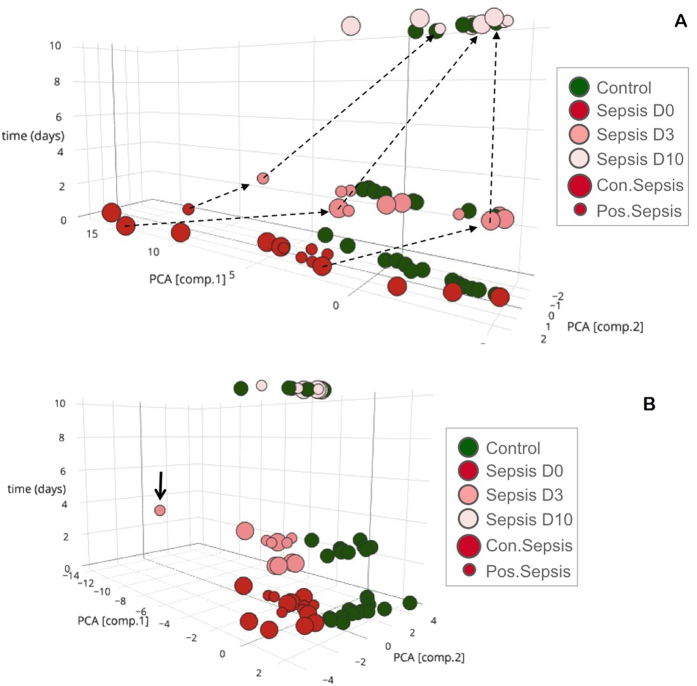
PCA scores plots.First and second component explaining the variation among data are plotted at three time-points D0, D3 and D10. Top Frame: 1H-NMR data: Samples of DO show clear separation of the two groups (septic patients versus controls). On D3 separation is not as evident, while on D10 samples cluster all together Bottom frame: LC-MS/MS data: Samples of DO and D3 show clear separation of the two groups (septic patients versus controls). On D10 samples cluster all together. The arrow indicates a deceased septic neonate on day 3. Green circles correspond to controls and red circles to sepsis subjects (smaller circles denote possible and large circles confirmed sepsis). Pink correspond to day 3 and light pink to day 10.